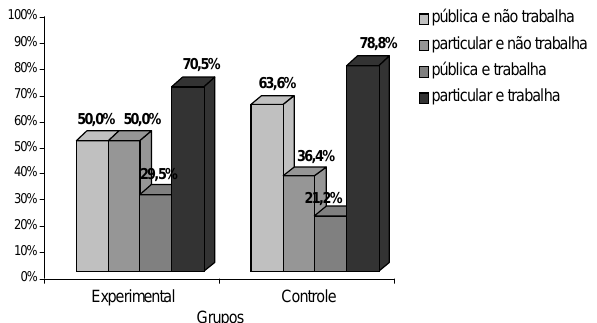
Figura 4. Distribui(cid:231)ªo dos grupos pesquisados de acordo Figura 4. Distribuição dos Grupos Pesquisados de Acordo com o Trabalho e o Tipo com o trabalho e o tipo de institui(cid:231)ªo no n(cid:237)vel